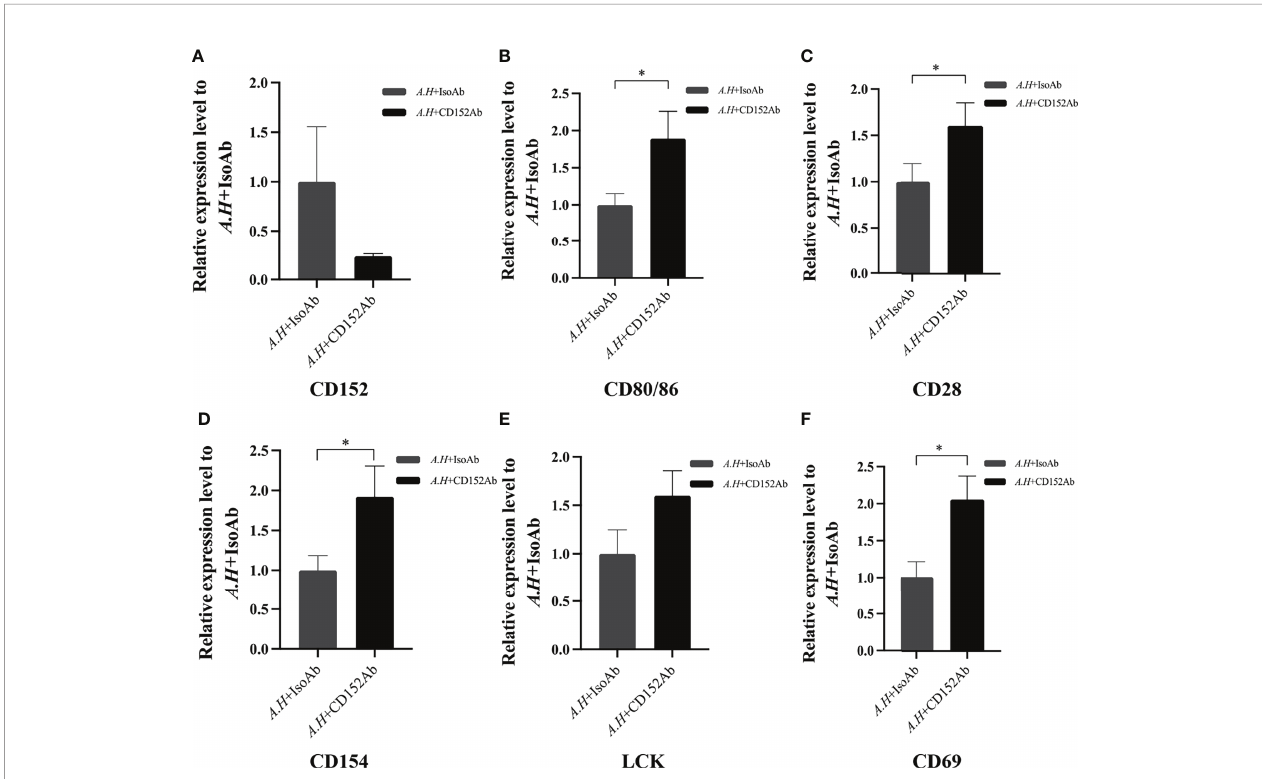
FIGURE 12 | Blocking CD152 by anti-CD152 pAbs on HKLs stimulated by A. hydrophila. The HKLs supplemented with the rabbit IgG isotype Abs were designated as the control group, and the HKLs supplemented with rabbit anti-grass carp CD152 pAbs as the experimental group. Six hours post-stimulation, the HKLs were harvested, the RNA isolated and the cDNA synthesized. (A) The mRNA expression level of CD152 . (B) The mRNA expression level of CD80/86 . (C) The mRNA expression level of CD28. (D) The mRNA expression level of CD154 . (E) The mRNA expression level of LCK . (F) The mRNA expression level of CD69 . The mRNA expression levels were analyzed by qPCR using the 2 − DD Ct method, with b -actin as the internal control. Data are presented as mean ± SEM (n = 5 fi sh). The p -value was calculated by one-way ANOVA with the LSD post hoc test (* p <